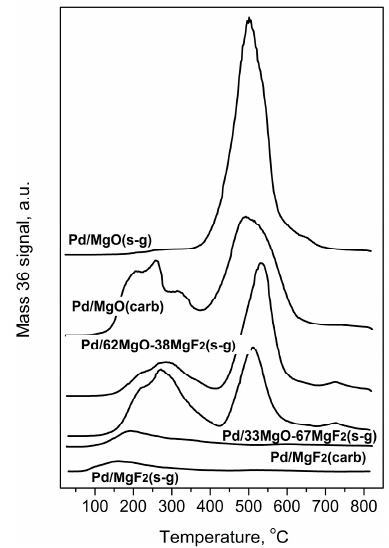
Figure 7. Evolution of HCl during Temperature Programmed Hydrogenation of post-reaction deposits from Pd/MgO-MgF 2 catalysts.